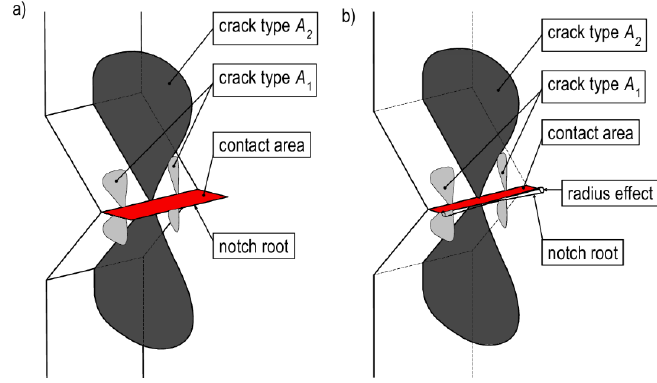
Figure 6. Cracks detected in specimens with ( a ) sharp V-notches and ( b ) rounded V-notches during loading.